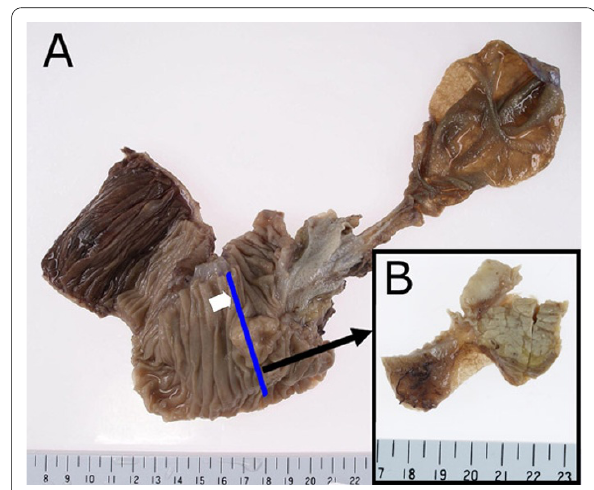
Figure 1 The surgical specimen . (A) A solid tumor measuring 25 × 30 × 25 mm in size was found at the papilla of Vater which was lobulated and covered by attenuated mucosa with ulcer formation at the center of elevation. (B) The section of the tumor extending from the mucosa to submucosa of the duodenum was sharply demarcated, solid, and white-yellowish.